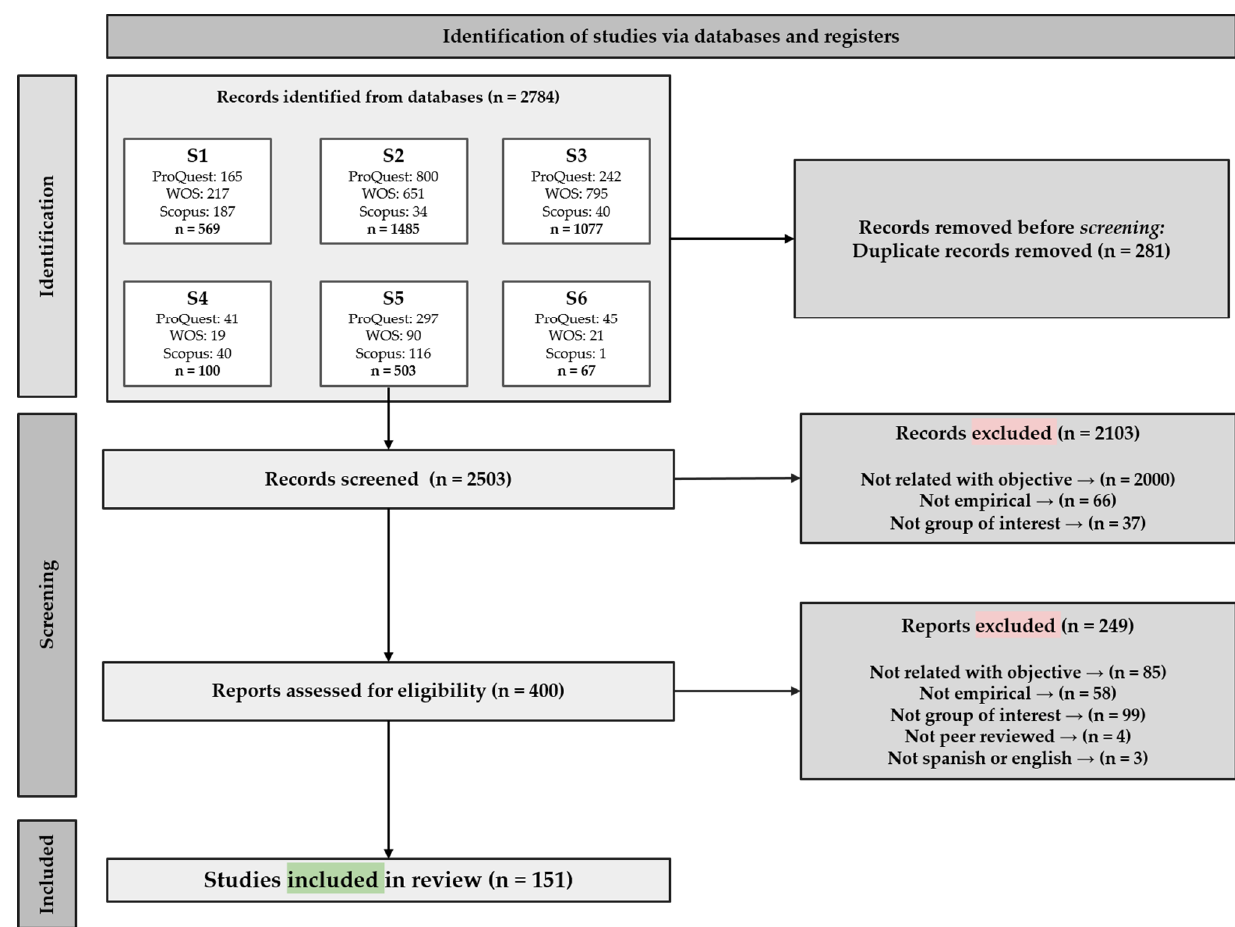
Figure 1. Flow diagram.